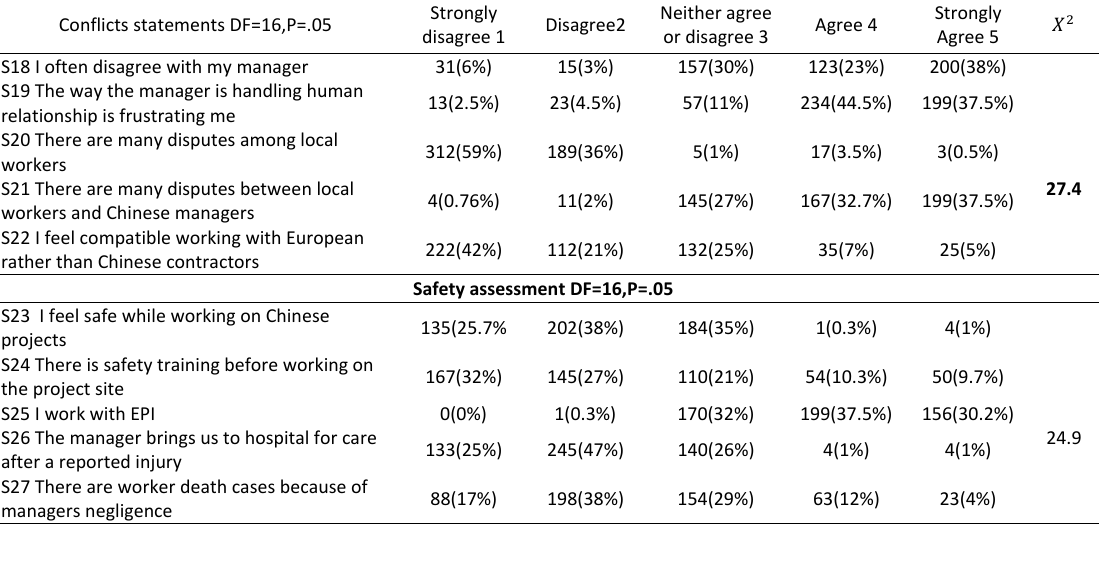
Table 7: Hypothesis testing on conflicts and safety